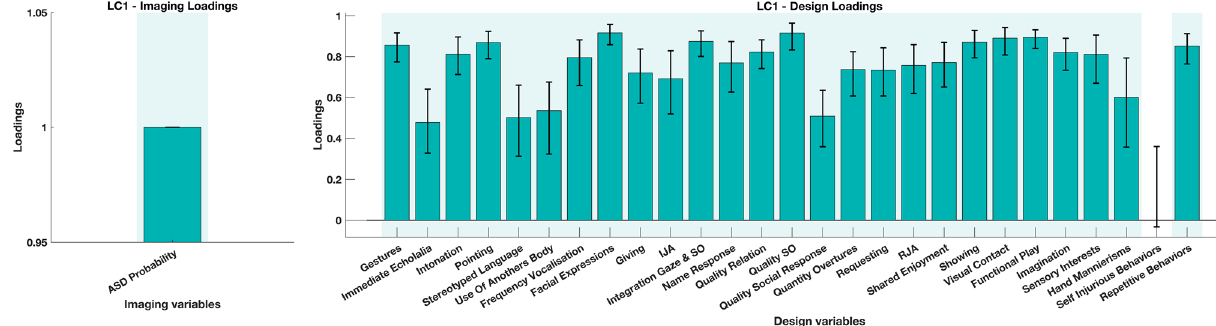
Figure 5. Loading on the latent component obtained using the Partial Least Squares Correlation (PLS-C) analysis. The cross-correlation matrix was composed on the behaviors (Y) side with 27 individual symptoms (gestures, immediate echolalia, intonation of vocalizations/verbalizations, pointing, stereotyped language, use of another’s body, frequency of spontaneous vocalizations, facial expressions directed to others, giving, IJA-initiation of joint attention, integration of gaze and another behaviors during social overtures, response to name, quality of relation, quality of social response, quality of social overtures (SO), requesting, RJA-response to joint attention, shared enjoyment in interaction, showing, unusual eye contact, functional play with objects, imagination, unusual sensory interest in play material/person, hand and finger and other complex mannerisms, self-injurious behaviors, unusually repetitive interests or stereotyped behaviors) and ASD Probability on the Imaging (X)